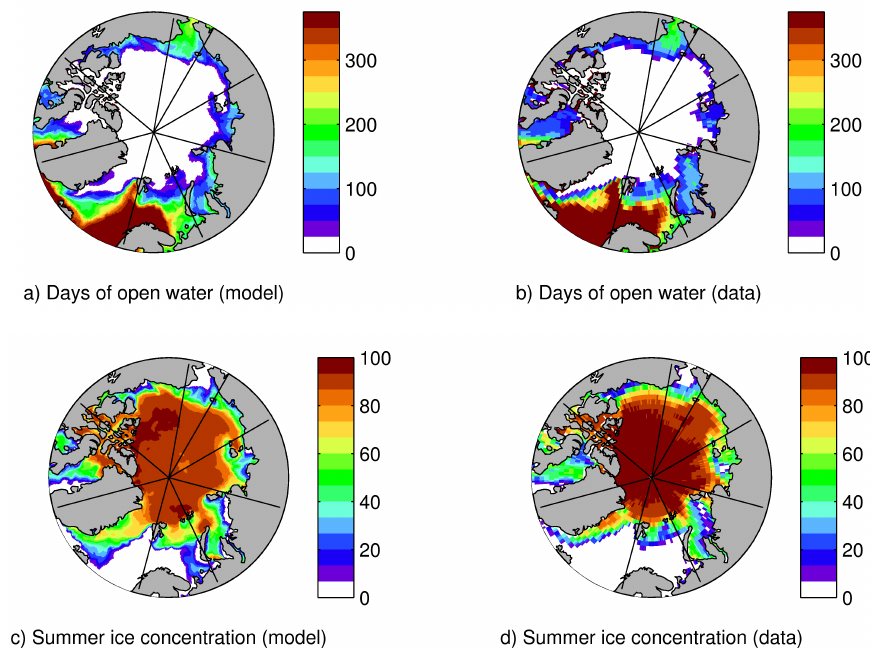
Fig. 3. Modelled (a) and observed (b) days of open water; modelled (c) and observed (d) summer (June, July, August) average ice concen- tration for year 1997. DFS4.1 data set used to force the model (Brodeau et